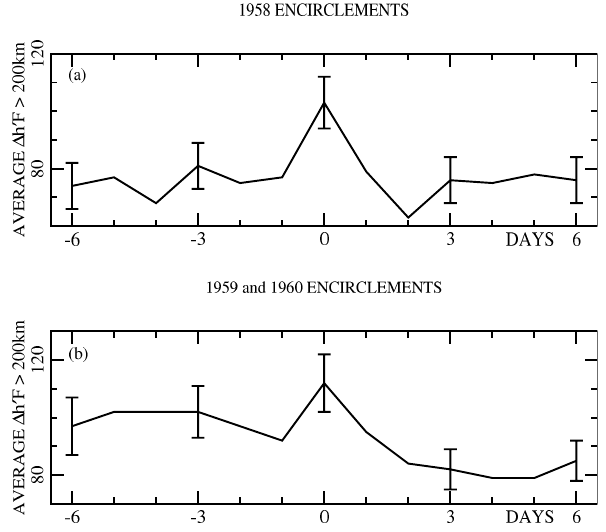
Fig. 4. Superposed-epoch analyses have been used for the Moscow OHT a events. The centre times indicates 1h 0 F increases 30h after the Moscow events. Average 1h 0 F displacements for times 6h be- fore and after the 30h events are also shown. (a) 1958 and (b) 1959 and